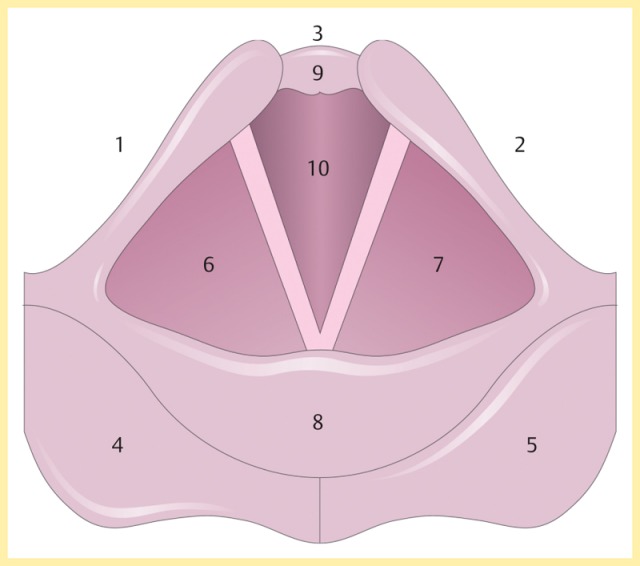
Laryngeal scheme with location of residues (1–5), penetration (6–9), aspiration (10) [29]